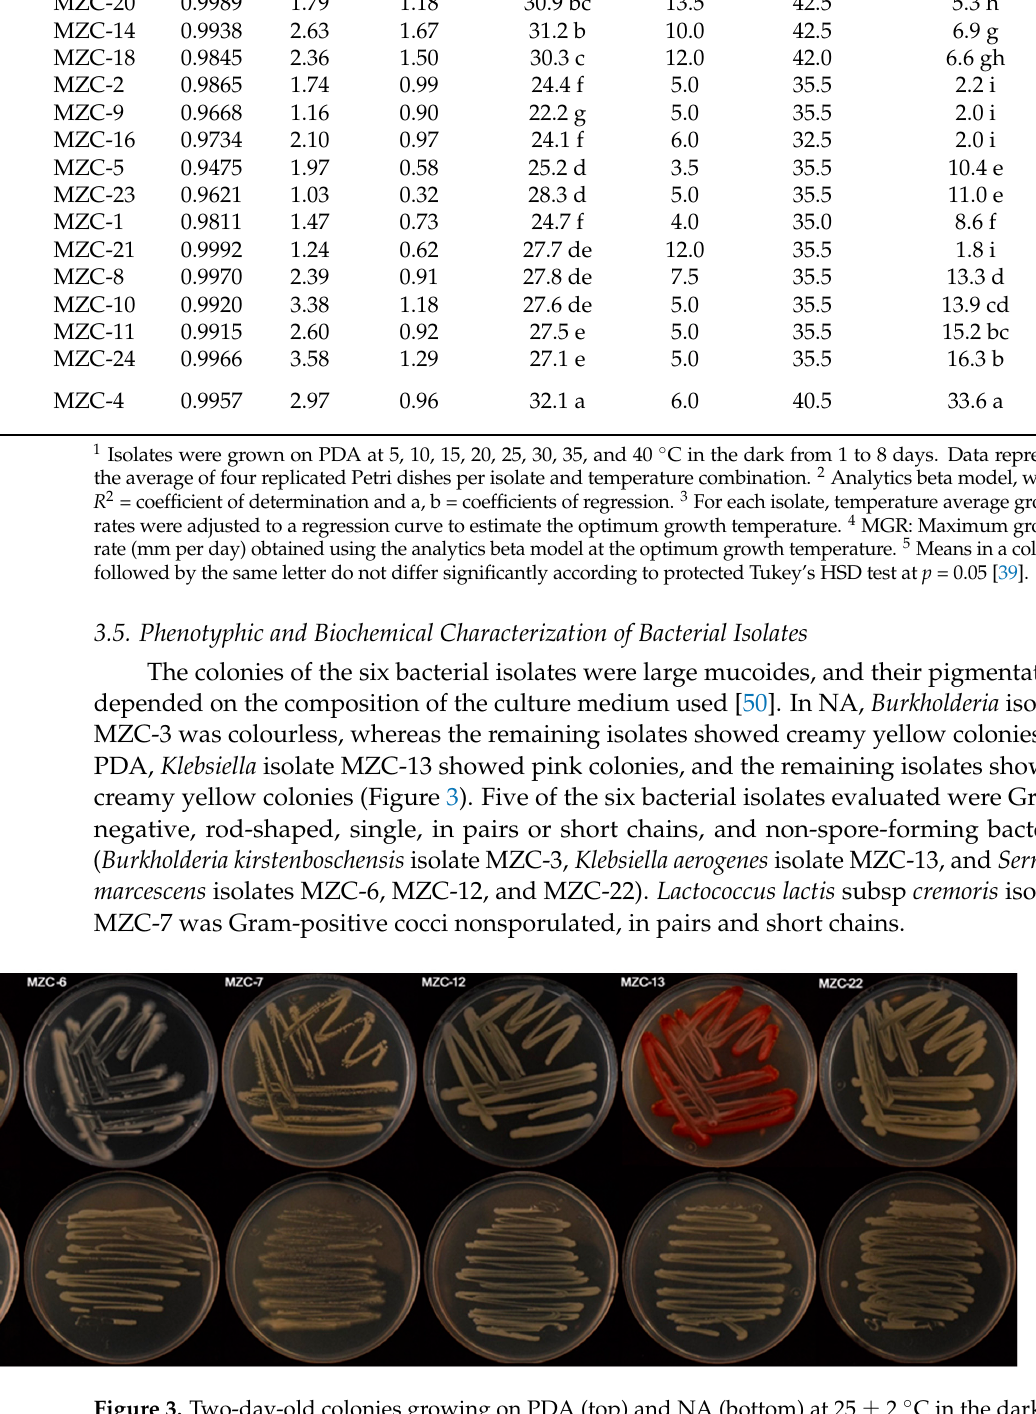
Figure 3. Two-day-old colonies growing on PDA (top) and NA (bottom) at 25 ± 2 ◦ C in the dark for 7 days of the six bacterial isolates characterized in this study and collected from degraded wood by the subterranean termites Reticulitermes grassei (For interpretation of the references of the isolates, the reader is referred to Table